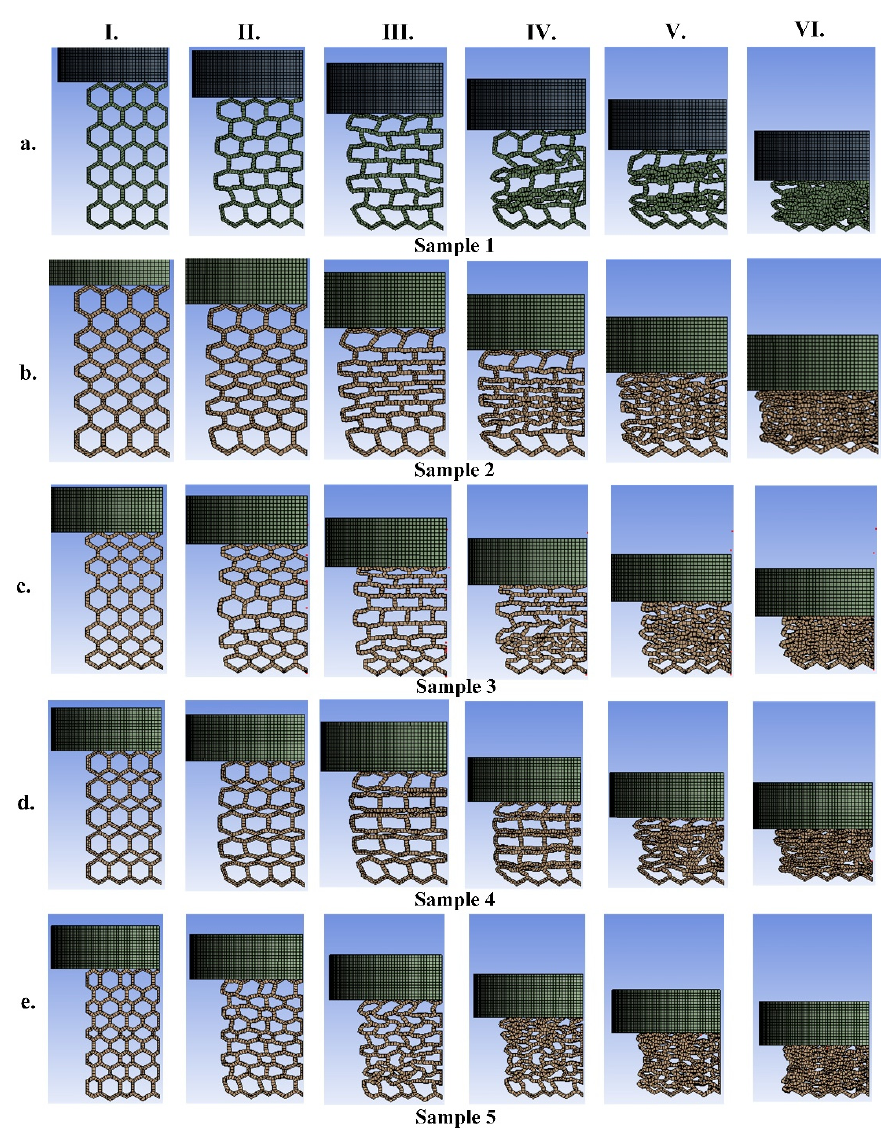
Figure 6. The deformation mapping of the samples 1 to 5 ( a – e ) made of TPC (each configuration from I to VI represents the current configuration at different displacements from 0.0033 to 0.02 m, with a displacement increment of 0.00334 m).